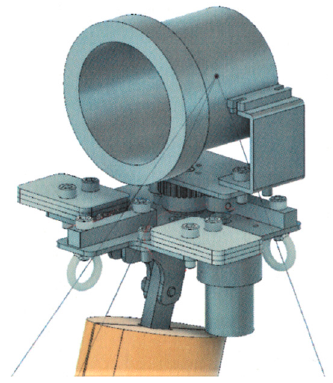
Figure 4. Sketch of the ducted fan.